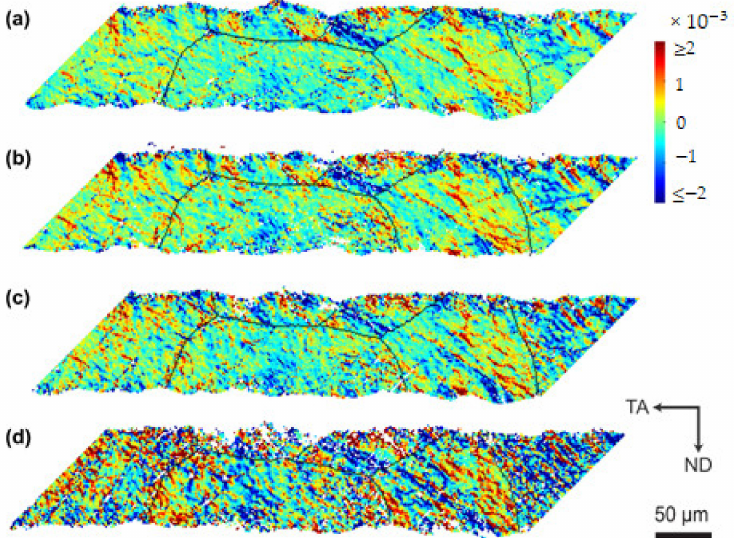
Figure 5. Maps of the deviatoric strain ε (cid:48) ND for the six Al grains at different tensile strains. ( a ) 0.23%; ( b ) 0.45%; ( c ) 0.83%; ( d )